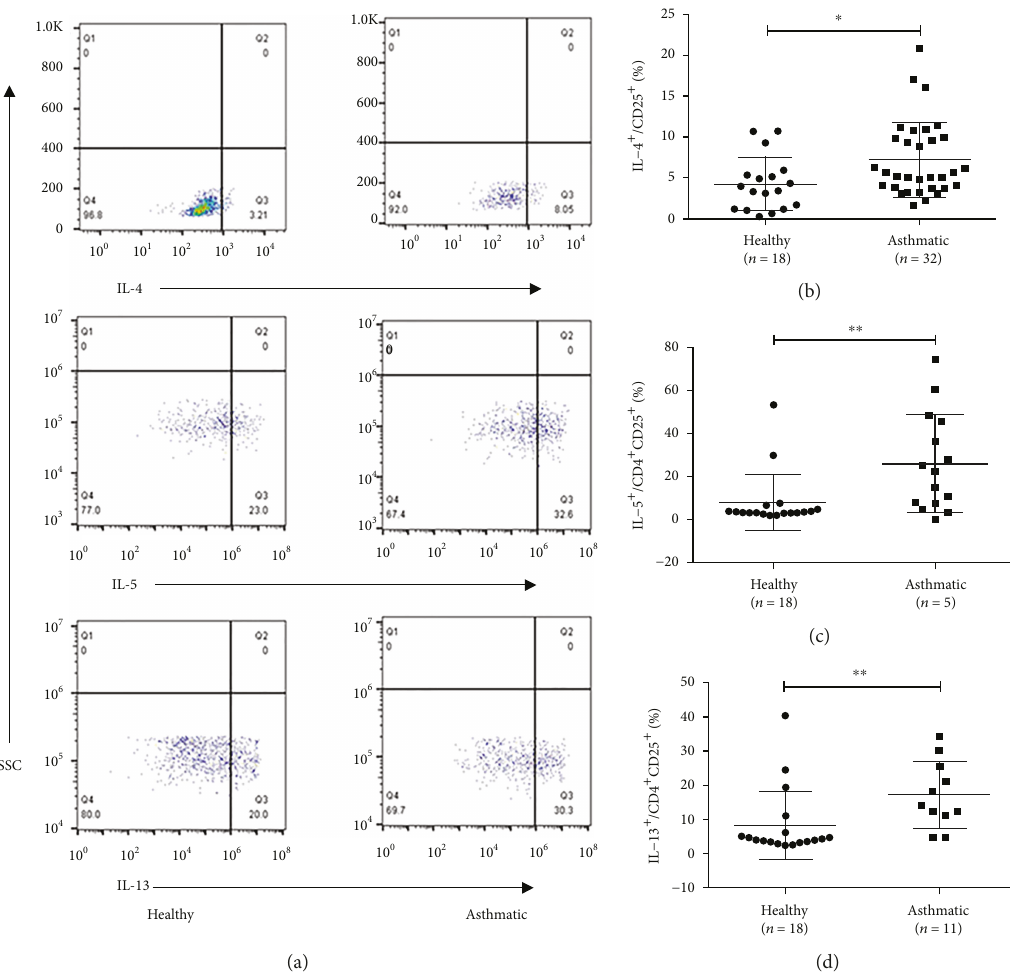
Figure 3: Increasing number of producing Th2-cytokine Treg cells. (a) Representative examples of fl ow cytometry analysis of IL-4, IL-5, and IL-13 production by CD4 + CD25 + Treg cells in healthy and asthmatic subjects. (b, c, d) Frequencies of IL-4, IL-5, and IL-13 production in healthy and asthmatic subjects. The graph shows means ± sem . ∗ p < 0 05 and ∗∗ p < 0 01 . NS: no signi fi